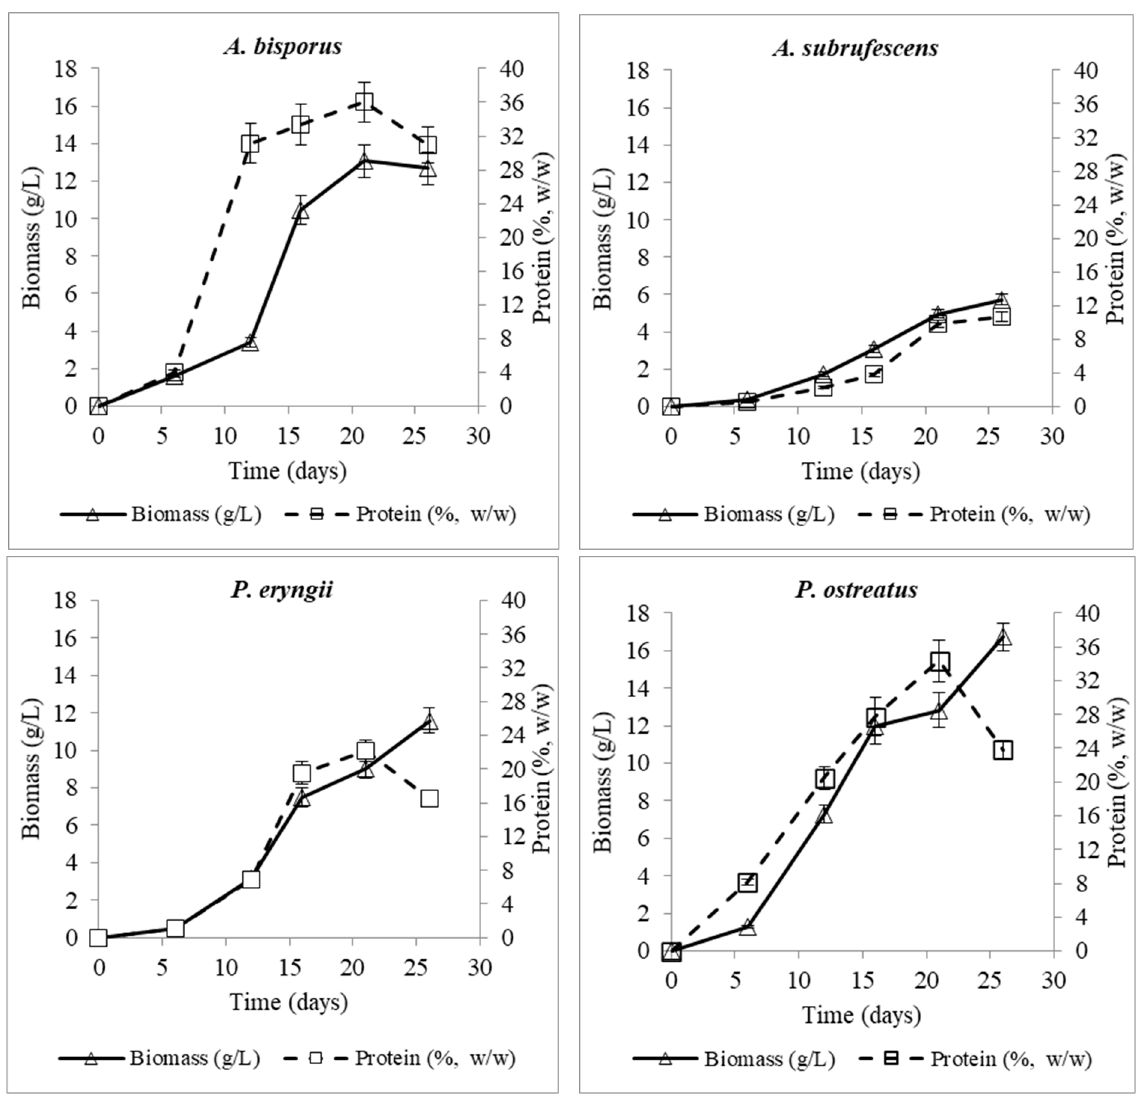
Figure 1. Production of biomass and total proteins of A. bisporus , A. subrufescens , P. eryngii and P. ostreatus during their culture in agitated (120 ± 5 rpm) flasks of C/N molar ratio 20, at 26 ±1 °C.